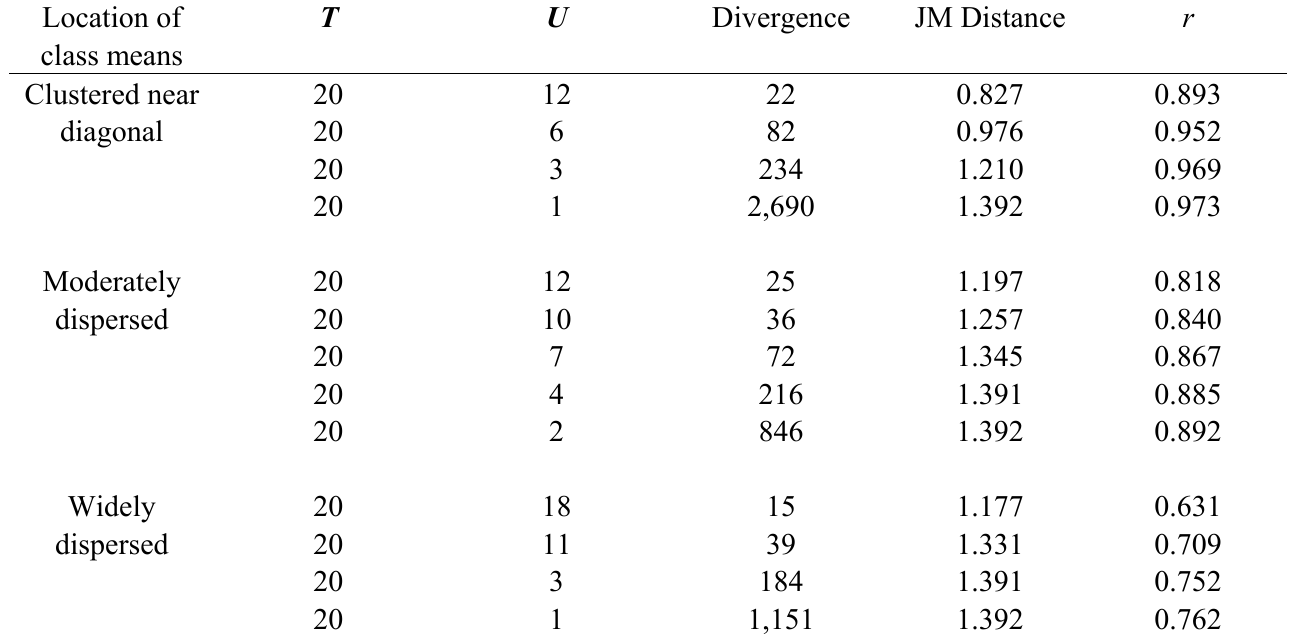
Table 4. Parameters used to construct simulated data for the band correlation experiment.